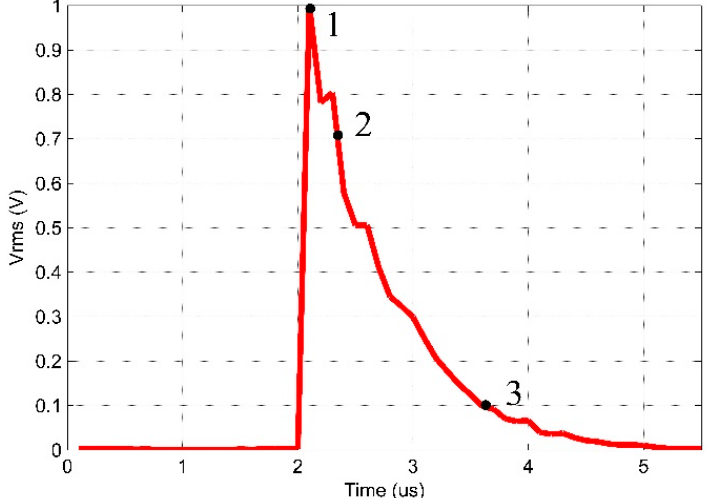
Figure 12. RMS values of the partial discharge signal obtained for the conventional AE sensor. Table 2. Points highlighted in Figures 11 and 12.